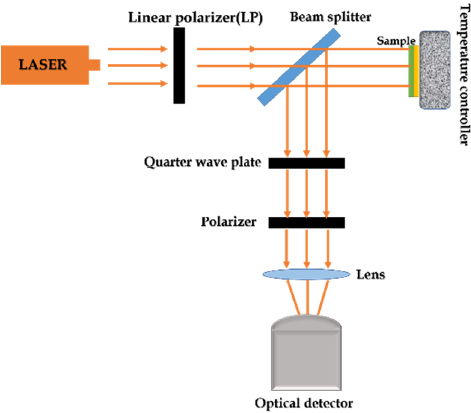
Figure 12. Schematic of the experimental device.